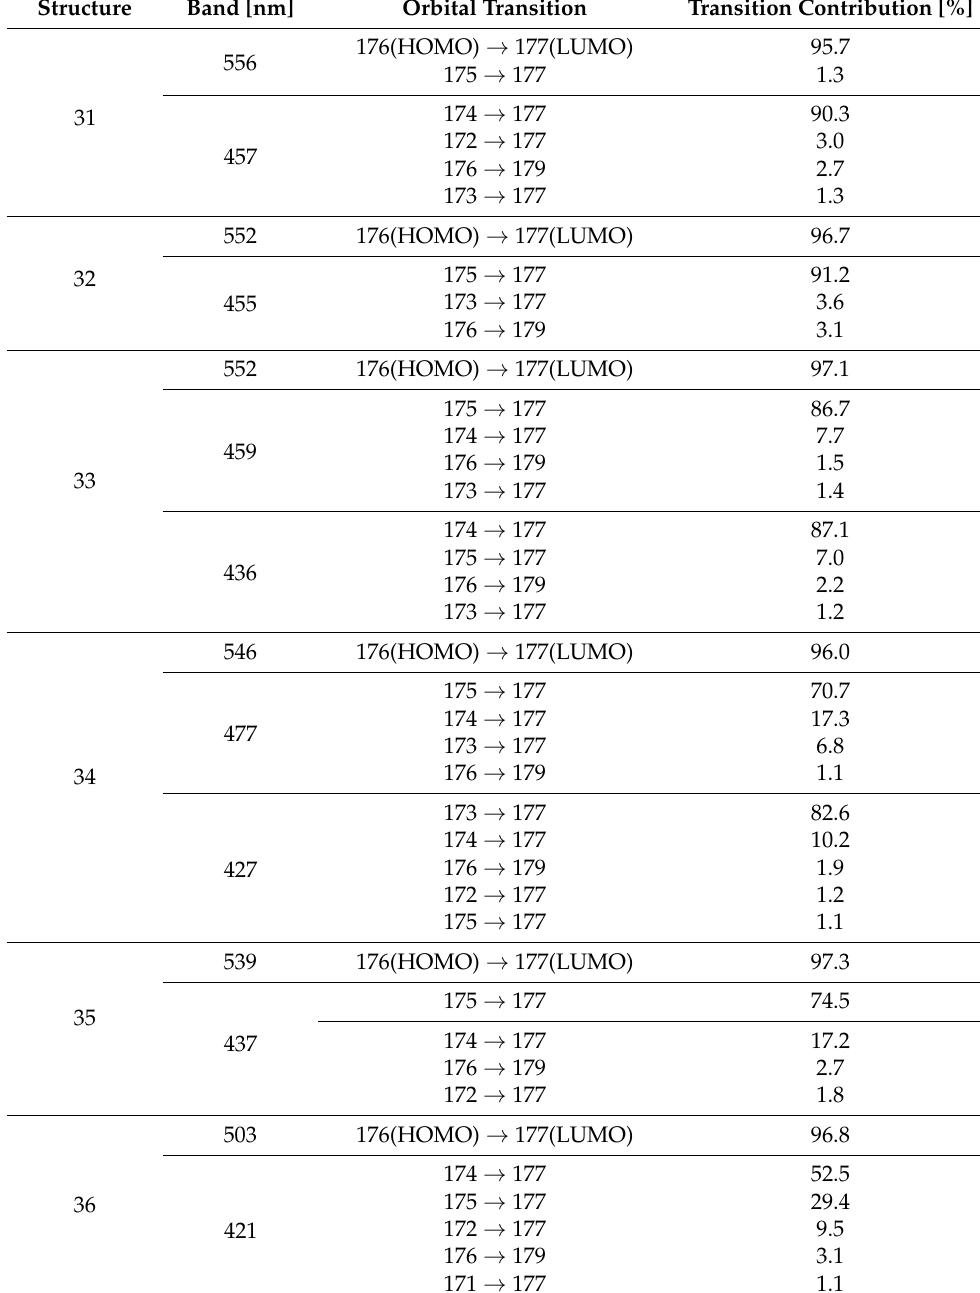
Table 4. The electron transition contribution and orbitals for fagopyrin F